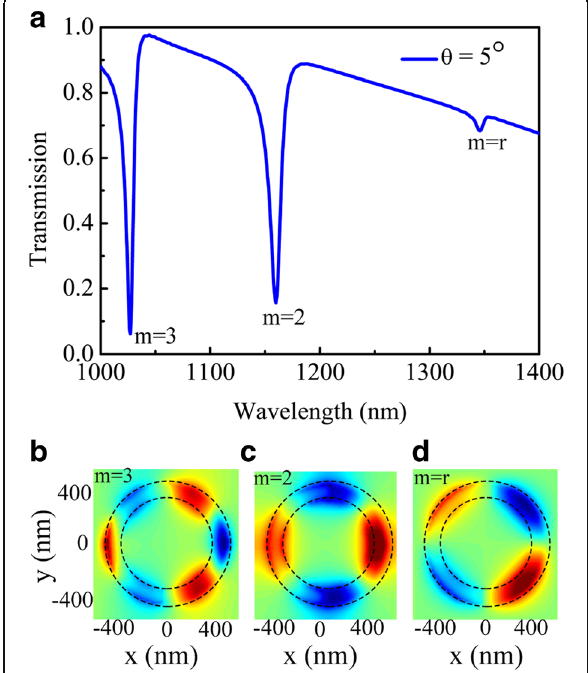
Fig. 4 a The spectral response of silver nanostructure with a changing angle θ = 5° of the half nanoring. Distributions of z -component of electric field at wavelengths of 1027 ( b ), 1160 ( c ), and 1346